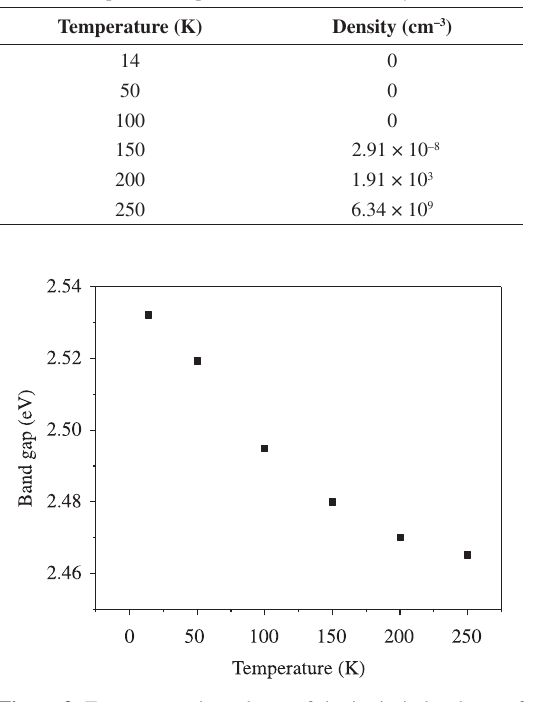
Figure 3. Temperature dependence of the intrinsic band gap of